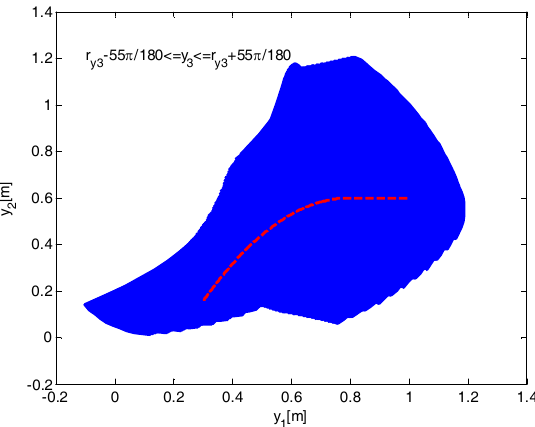
r (red). Figure 18. y